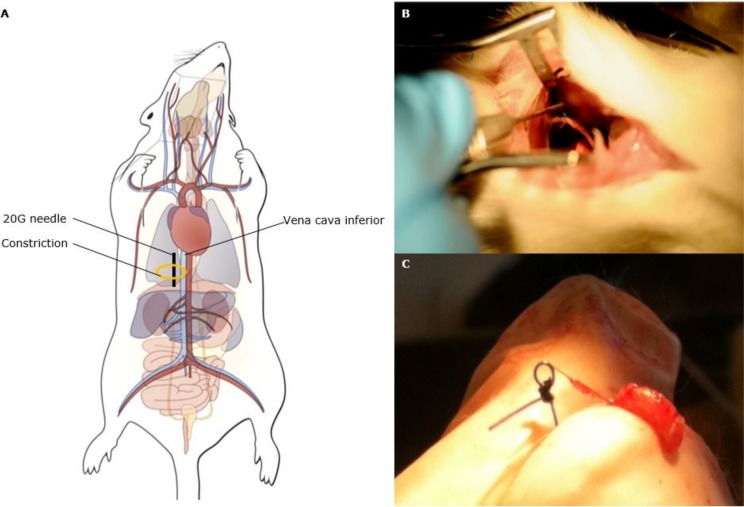
Characterization of a rat model of abdominal venous congestion by constriction of the thoracic inferior vena cava.Scheme of the experimental procedure to constrict the thoracic inferior vena cava (IVC) is shown in (A). Under isoflurane anesthesia and after endotracheal intubation, a right anterolateral thoracotomy was performed to reach the thoracic IVC and the vessel was dissected from the surrounding tissue. A permanent constriction was applied by tying a 6–0 prolene surgical wire (orange circle) around the thoracic IVC (light blue blood vessel) and a 20G needle (0.812 mm, black line), after which the needle was removed. Sham-operated rats were subjected to the same surgical procedure without application of the constriction. Figure adapted from Watts et al. 2012 [19]. Visualization of the constriction of the thoracic IVC in situ (B) and the constriction was correctly applied in all 7 IVCc rats, as confirmed by visualization of the constriction after killing the rats humanely (C).